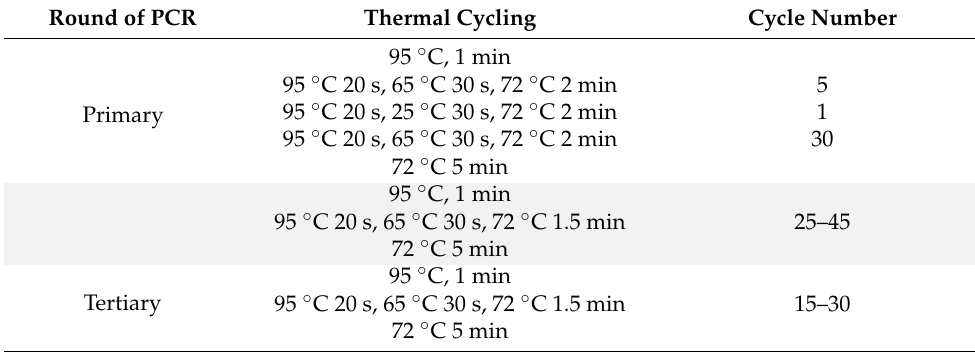
Table 2. Thermal cycling parameters of bridging